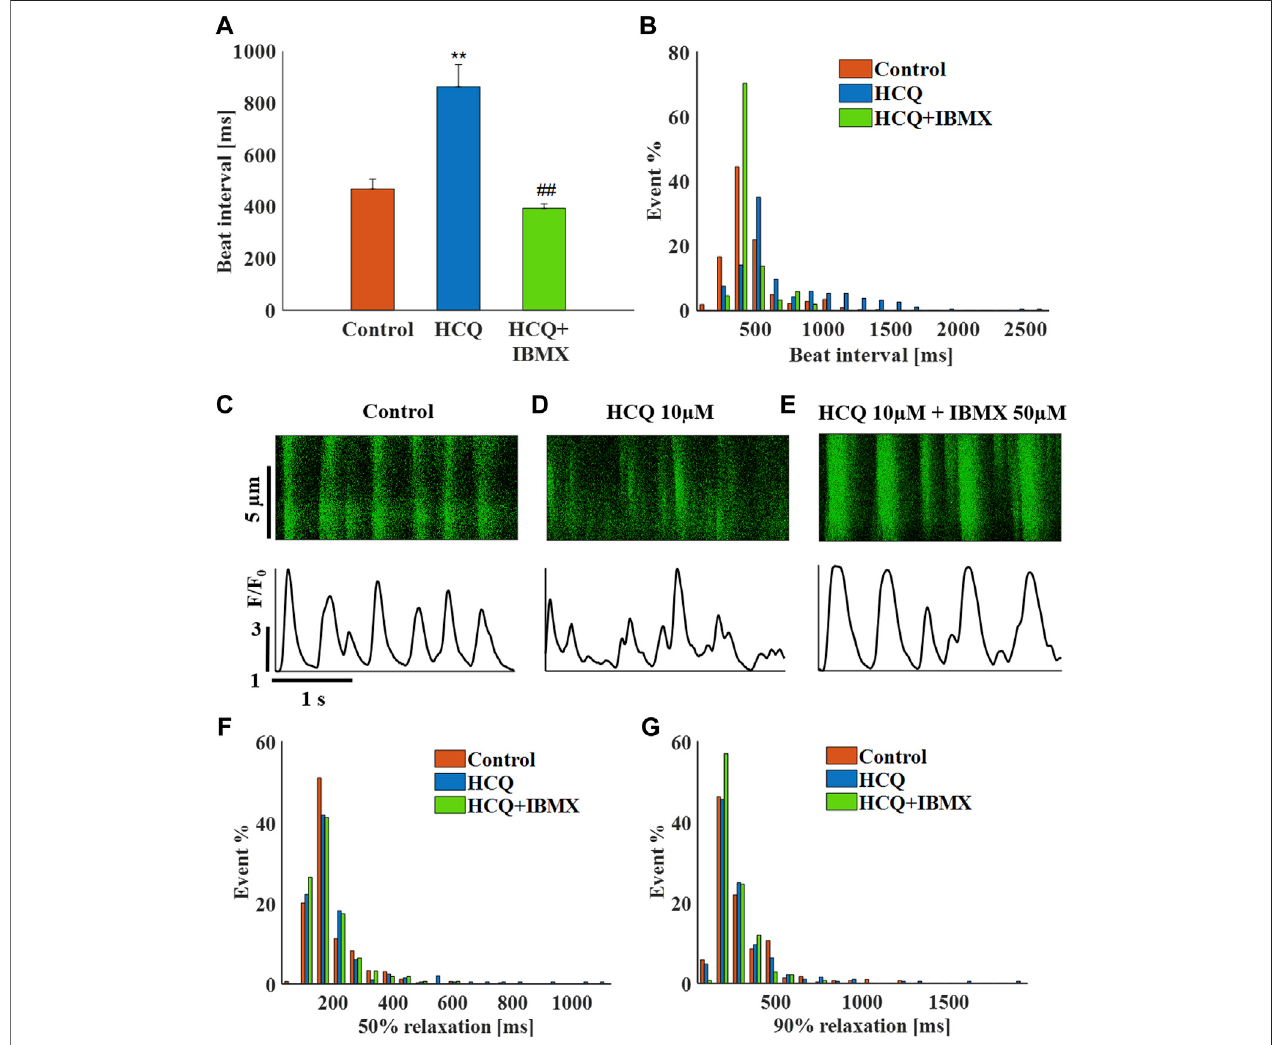
FIGURE 8 | The effect of hydroxychloroquine (HCQ) with 3 ′ -isobutylmethylxanthine (IBMX) on mouse SAN cells residing in the sinoatrial node. (A) Mean beat interval and (B) beating interval distribution of control and of 10 μ M HCQ ( n = 23) or 10 μ M HCQ and 50 μ M IBMX-treated mouse sinoatrial nodes (SANs) ( n = 13). Representative example of Ca 2+ transients in (C) control and in (D) 10 μ M HCQ- or (E) 10 μ M HCQ and 50 μ M IBMX-treated SANs. The distribution of (F) 50% and (G) 90% Ca 2+ transient relaxation times in control and in 10 μ M HCQ- or 10 μ M HCQ and 50 μ M IBMX-treated SANs. ** p < 0.01 vs. baseline, ## p < 0.01 vs. 10 μ M